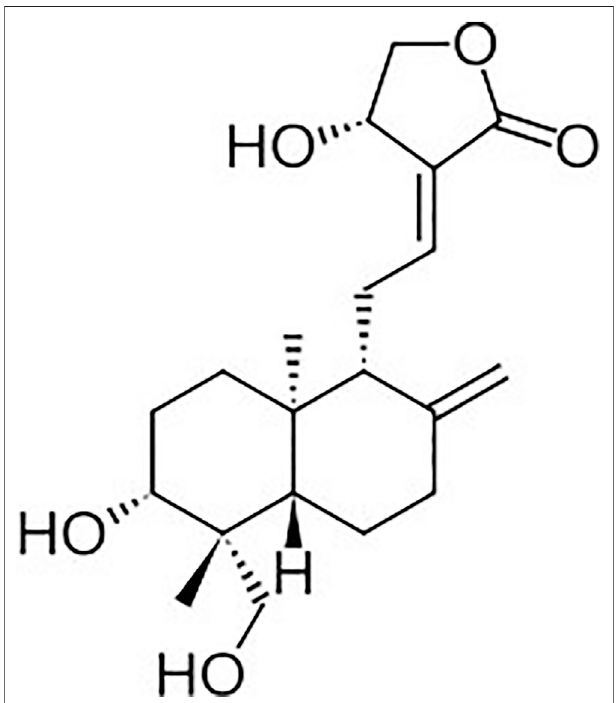
FIGURE 5 | Chemical structure of andrographolides.